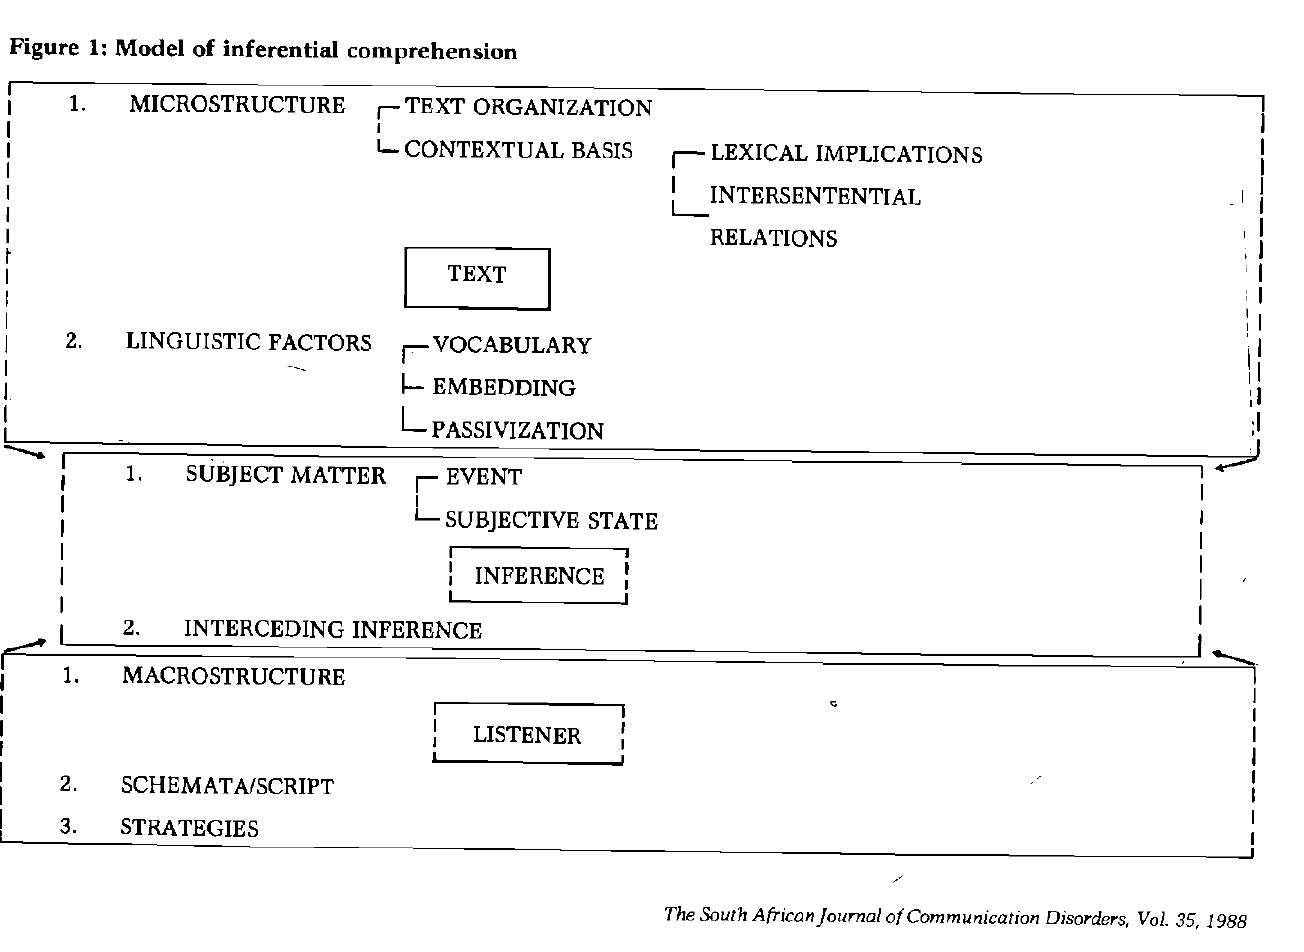
Figure 1: Model of inferential